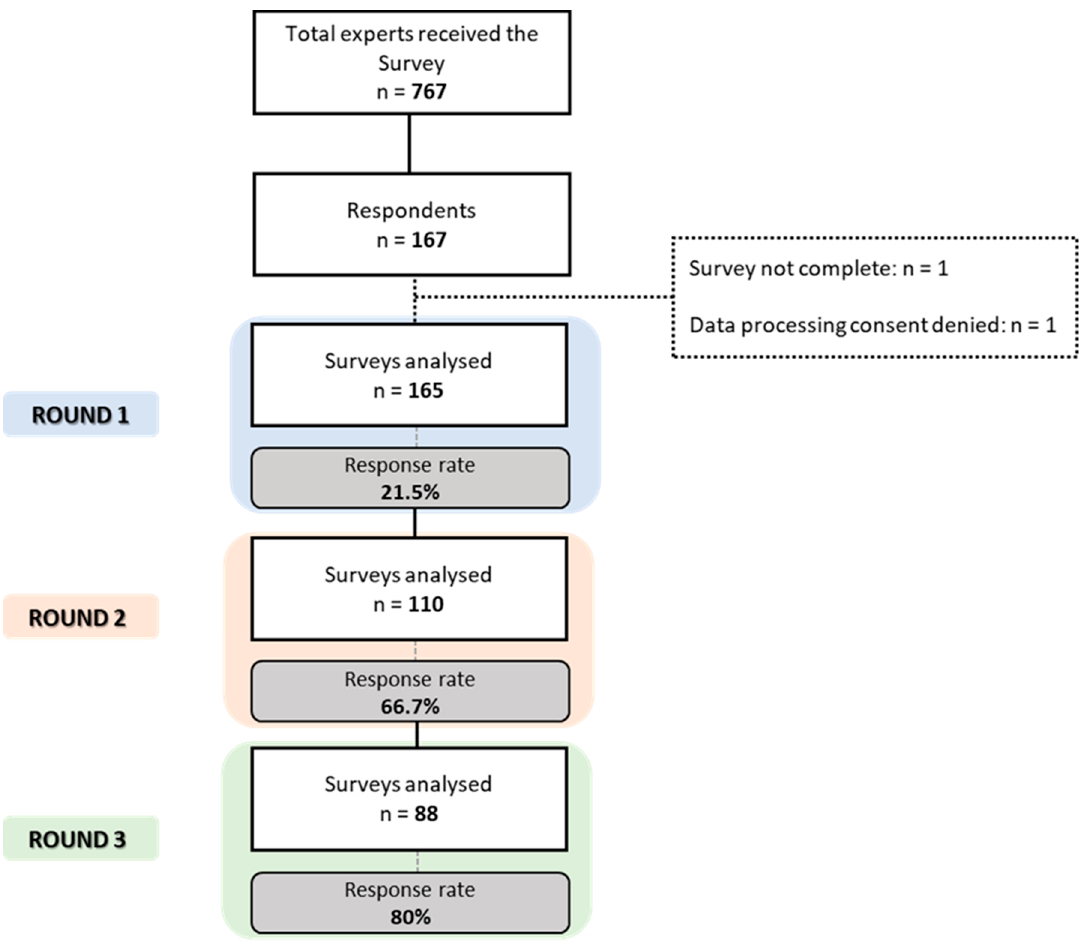
Figure 2. Identification process of Italian experts in Adherence research